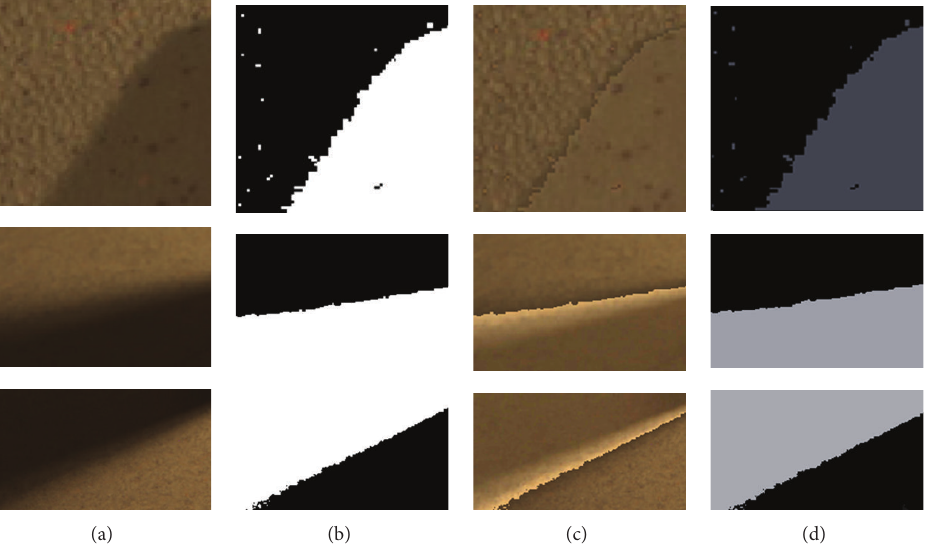
Figure 9: Sampled shadow regions, detected shadow mask, shadow-free image, and strength of